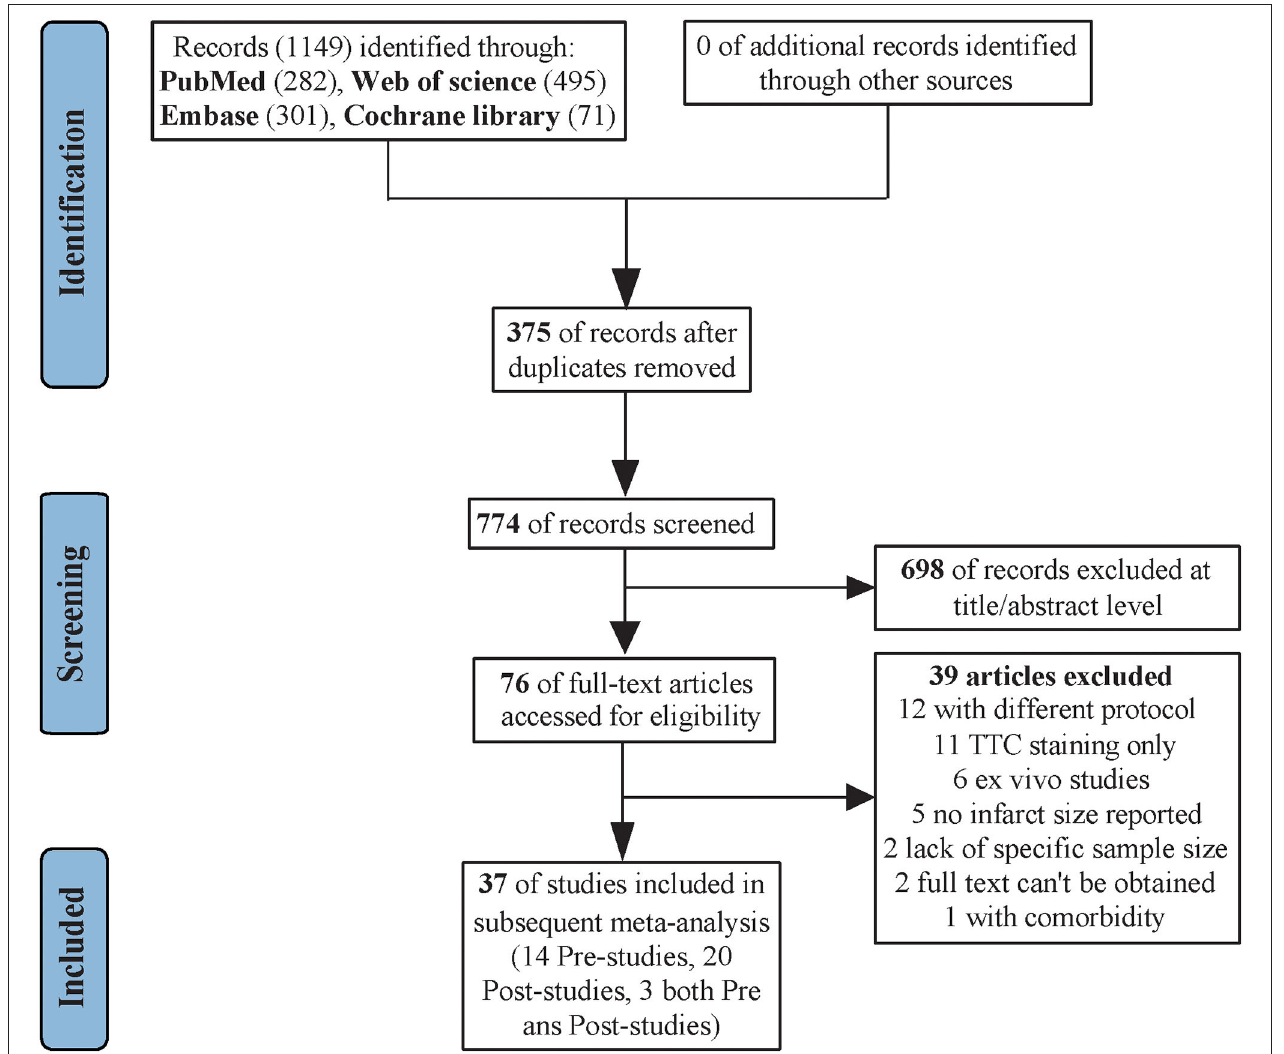
FIGURE 1 | Flow diagram of the study selection